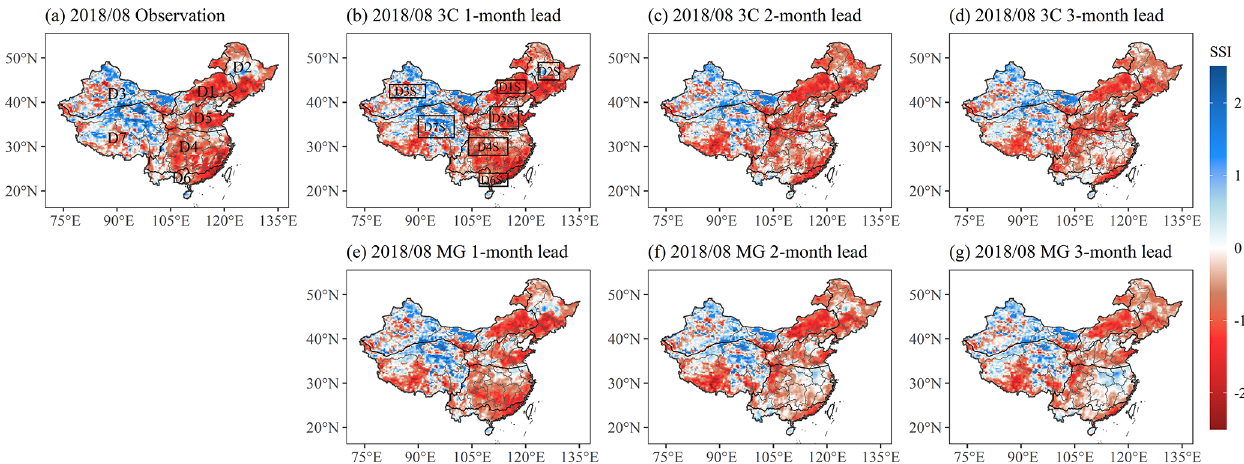
Figure 6. SSI observations in August of 2018 (a) as well as the corresponding SSI forecasts for 1- to 3-month lead times utilizing the 3C-vine model (b–d) and the MG model (e–g) over China. The black rectangles (as shown in b ) denote the typical areas (corresponding to D1S–D7S) selected in climate regions